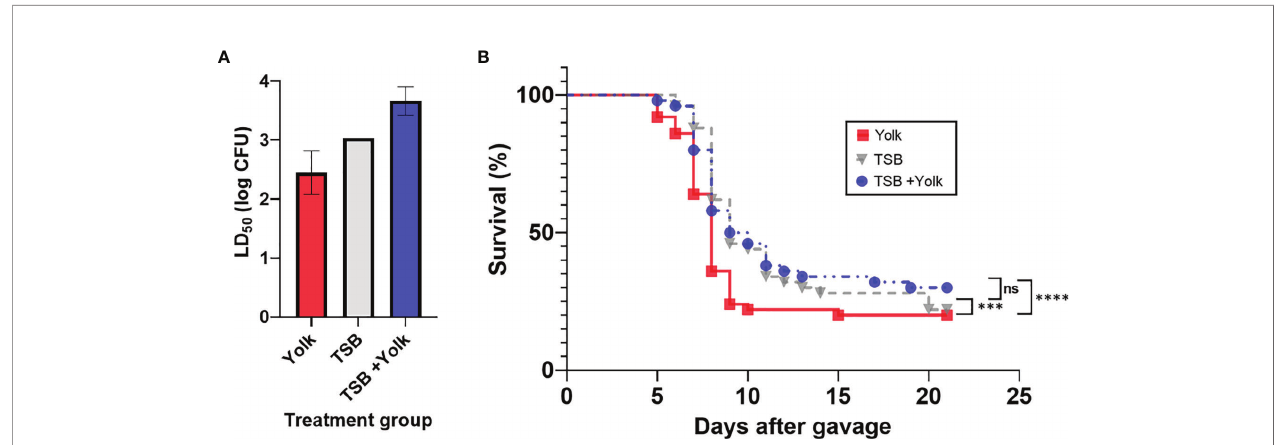
FIGURE 1 | Pathogenicity of Salmonella Enteritidis to mice that were fed, through oral gavage, the pathogen that was grown in egg yolk (yolk), tryptic soy broth (TSB), or grown in TSB followed by the administration of sterile egg yolk (TSB+Yolk). (A) Lethal dose 50 (LD 50 ) of various treatment groups; data from the two independent repeats were combined to calculate LD 50 ; error bar stands for standard error. (B) Survival curves for mice challenged with Salmonella Enteritidis; data from the two independent repeats (at all Salmonella inoculation levels) were combined. Statistical signi fi cance: (ns) not signi fi cant, p ≥ 0.05; (***) p < 0.001; (****) p <